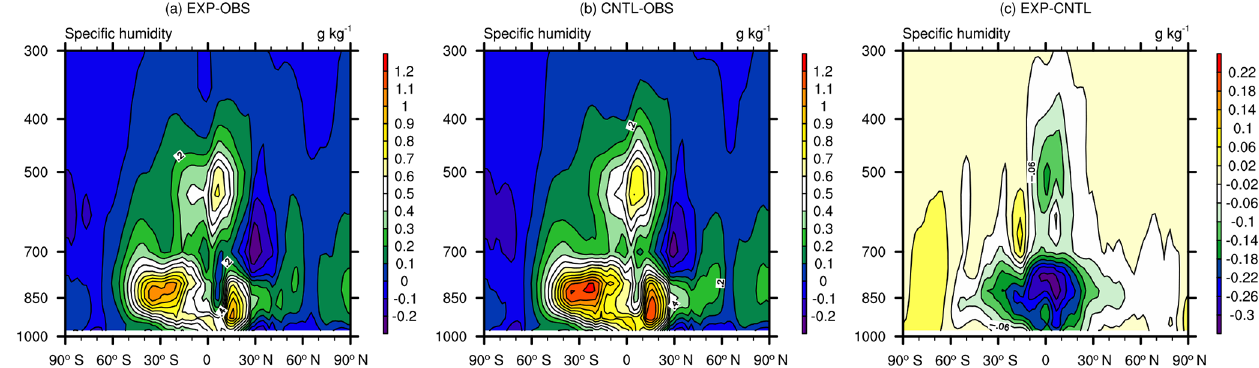
Figure 7. Pressure–latitude distributions of specific humidity of (a) EXP–OBS, (b) CNTL–OBS, and (c) EXP–CNTL.